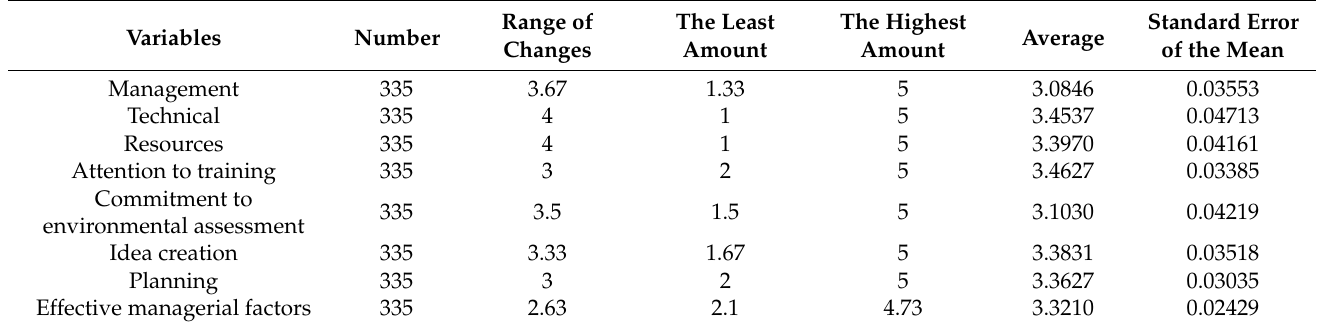
Table 32. Central indices and dispersion of variables related to research factors.